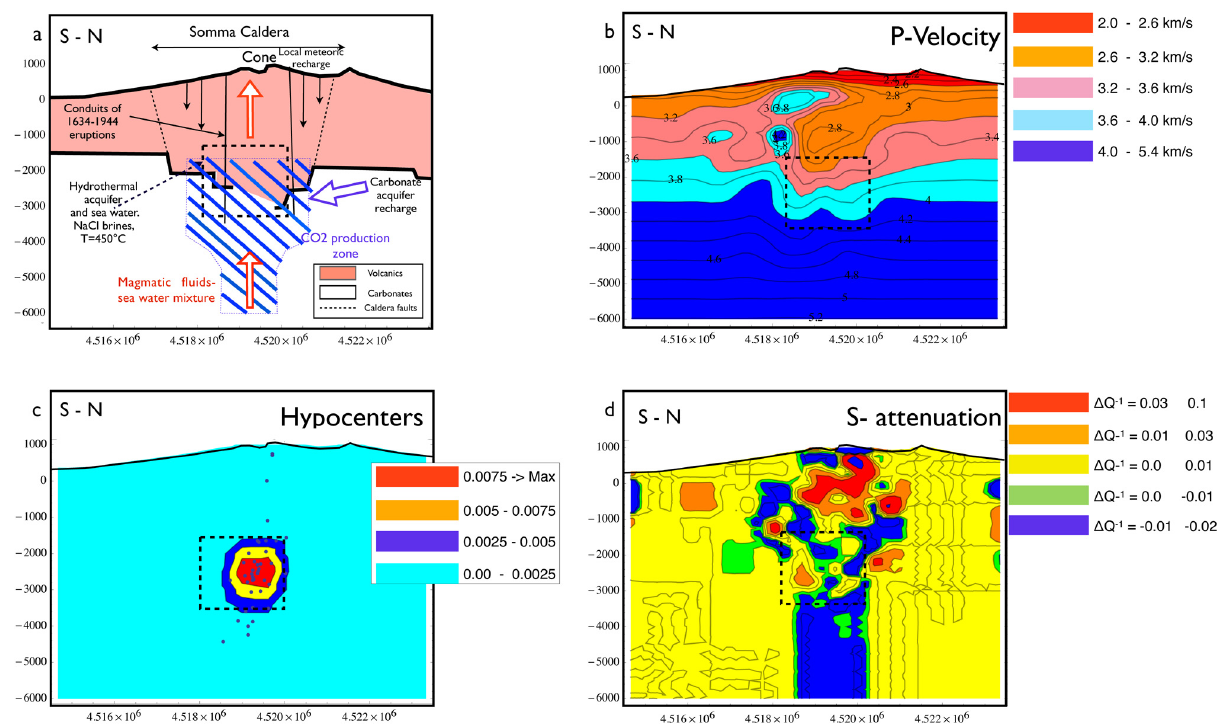
Figure 4. (a) S-N oriented conceptual geochemical model of the Vesuvius hydrothermal system inferred by chemical and isotopic compo- sitions of fumarolic fluids discharged at bottom crater [Chiodini et al. 2001, Caliro et al. 2011]. The hydrothermal aquifer is bordered by a thick black line, which is reported for clarity also in the other three panels; (b) S-N section of the P velocity image; (c) S-N section of the lo- cation probability for earthquakes in the magnitude range between 2.5 and 3.6; (d) S-N section of the differential S wave attenuation